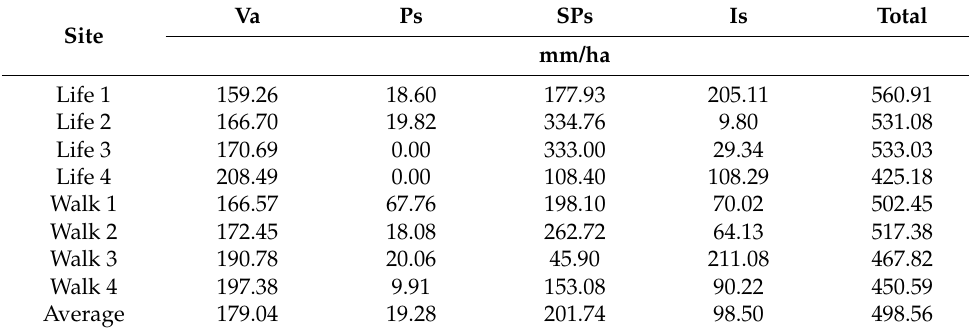
Table 4. Results of evaluating the runoff rate per land use type of the study